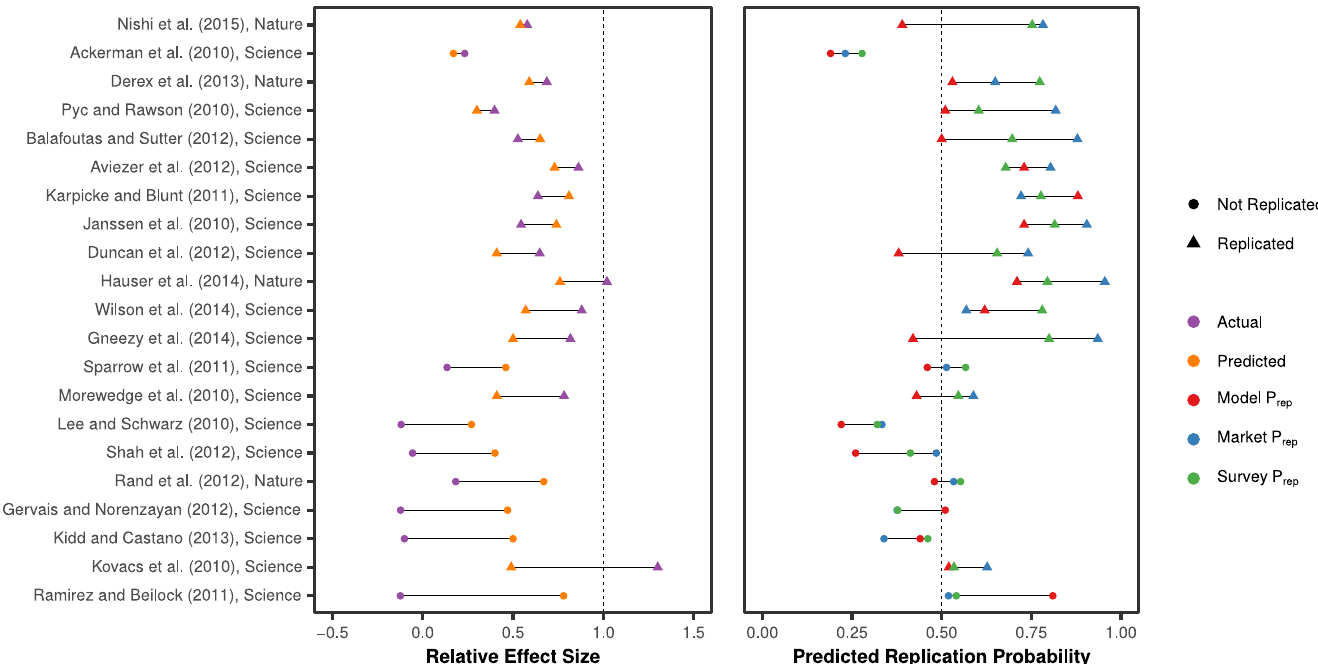
Fig 5. Predicted and actual results of the SSRP. Model predictions were registered before the experiments had been conducted. The left panel shows predicted relative effect size in purple and actual in orange, sorted by increasing prediction error. Right panel shows replication probability as predicted by the model, a prediction market, and a survey respectively. Data points are represented by a triangle when the replication was successful ( p < 0.05 and an effect in the same direction). To see when the model made a correct prediction at the 50% probability threshold study the right panel. Red triangles on the right side of the dashed line and circles on the left side have been predicted